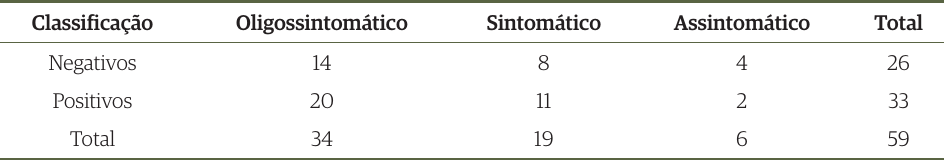
Figura 2. Parasitológico imprint de baço de cão soropositivo para leishmaniose. Macrófago (seta maior), contendo formas amastigotas (seta de duas pontas). Panótico Rápico, aumento de 100x. Tabela 1. Número de animais positivos ou negativos no teste parasitológico de acordo com a sintomatologia clínica, Uberlândia - MG, 2010.